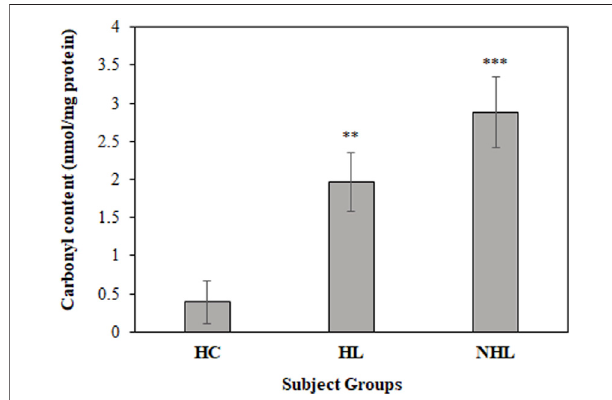
FIGURE 2 | Detection of carbonyl contents in serum samples of HL and NHL patients. Healthy individuals were used as controls. ** p < 0.01 and *** p < 0.001.